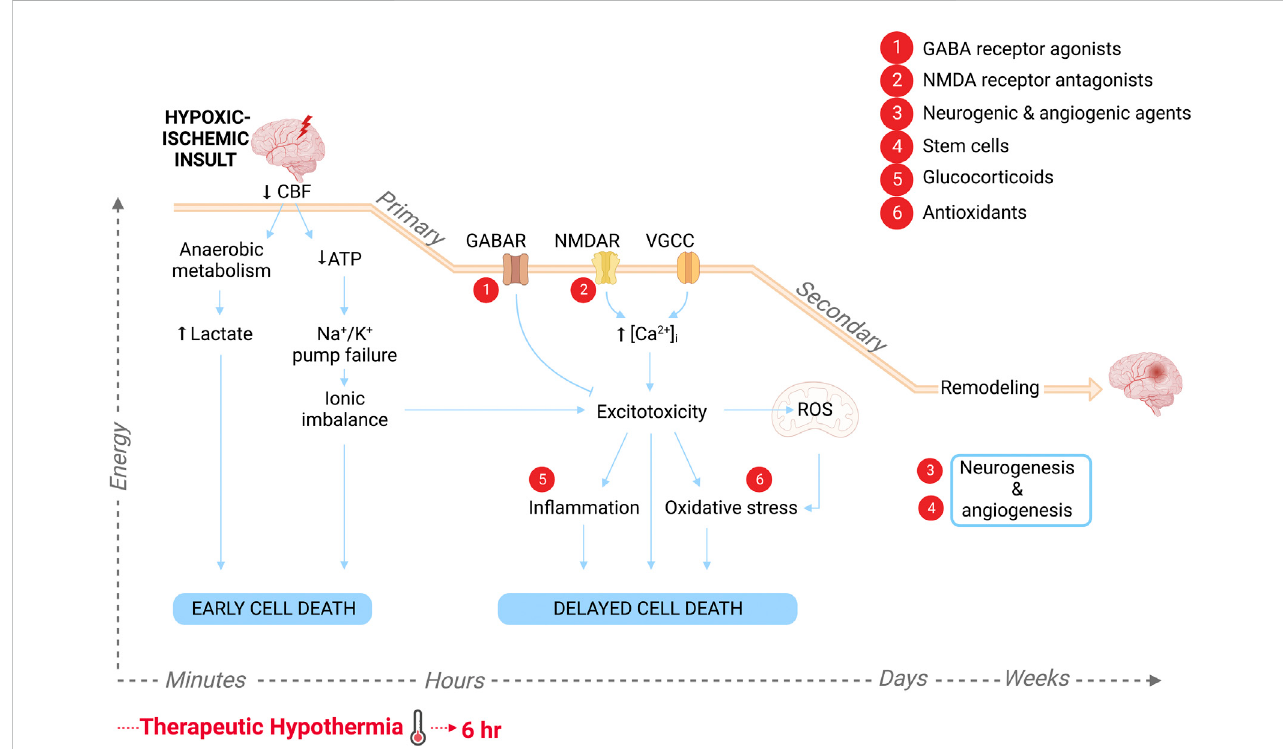
Schematic of the pathological progression in the brain following HI insult and the molecular targets of the various adjuvant therapies to hypothermia, labeled 1 – 6. Primary energy failure is characterized by a drop in cerebral blood fl ow (CBF) leading to lactate accumulation and high energy